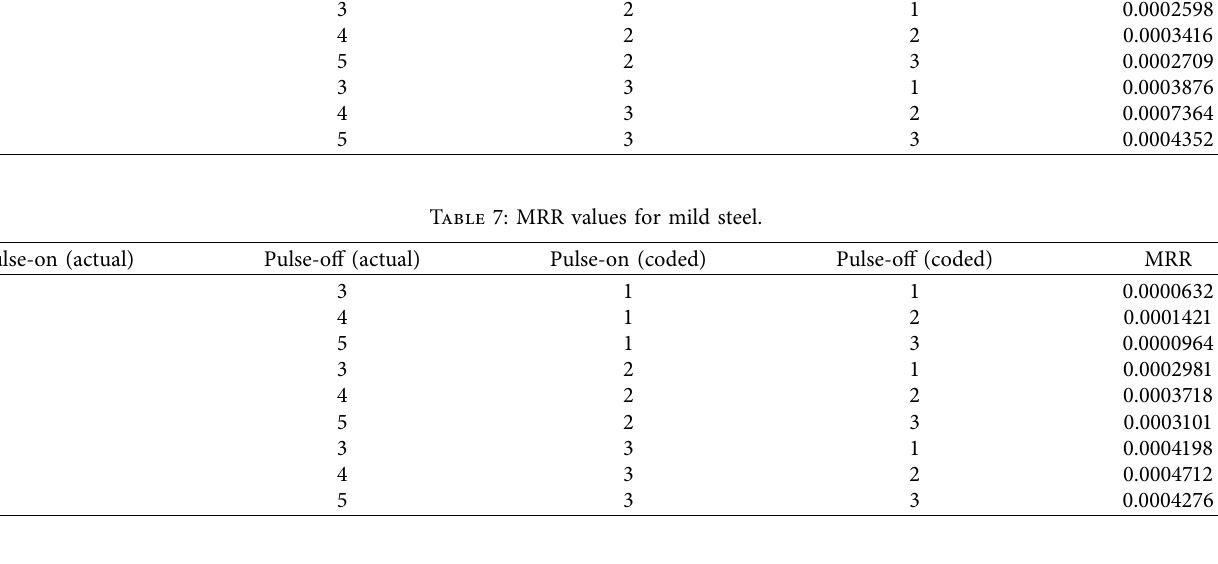
Table 8: MRR at different levels of pulse-on time.